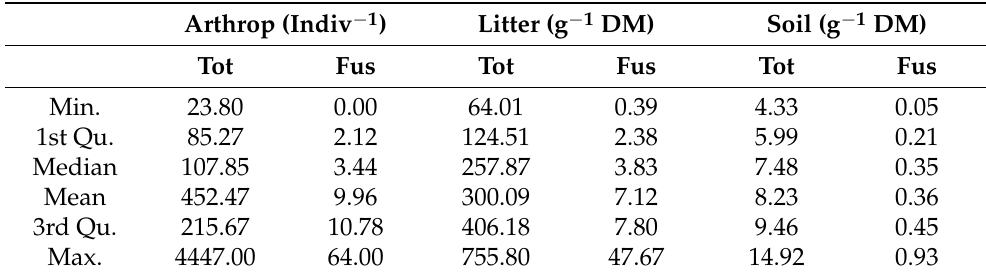
Table 1. Descriptive data of quantified total fungal (Tot) and Fusarium (Fus) colony forming units from the body surface of collected arthropods (Arthrop (Indiv − 1 ), and from litter and soil samples (g − 1 DM).